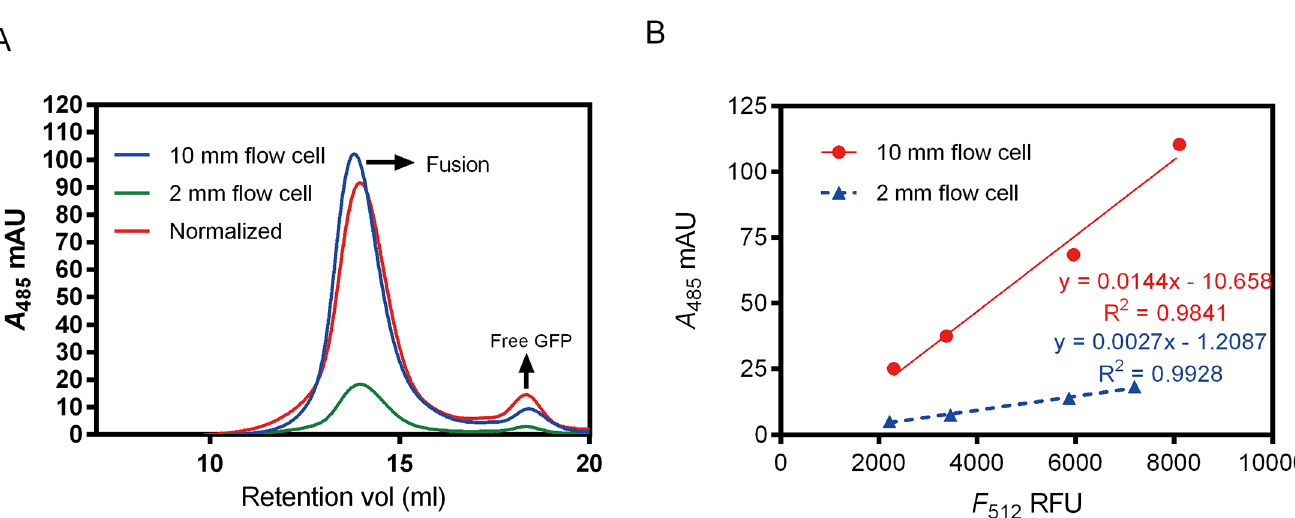
Fig 2. Signal enhancement of EGFP absorption using 10 mm path-length flow cell. (A) FA-SEC profiles of detergent solubilized membranes containing ~160 μ g ASBT NM -EGFP-His8 recorded by 2 (green trace) and 10 mm (blue trace) path-length flow cells. The normalized profile (red trace) is plotted using the A485 in FA-SEC profile of 2 mm flow cell multiplied by 5. (B) Correlations of peak absorption ( A 485 ) and fluorescence ( F 512 ) acquired from the FA-SEC and FSEC profiles of different serial diluted ASBT NM -EGFP-His8 DDM-solubilized membranes (approximately containing 160, 80, 40, and 20 μ g of ASBT NM -EGFP-His8 from high to low concentrated samples) injected in Seuperose 6 column, as exampled in Fig 3. The intensities of absorption maxima collected by 10 and 2 mm path-length flow cells are plotted as red and blue lines, respectively. Each data point represents different serial diluted detergent-solubilized crude